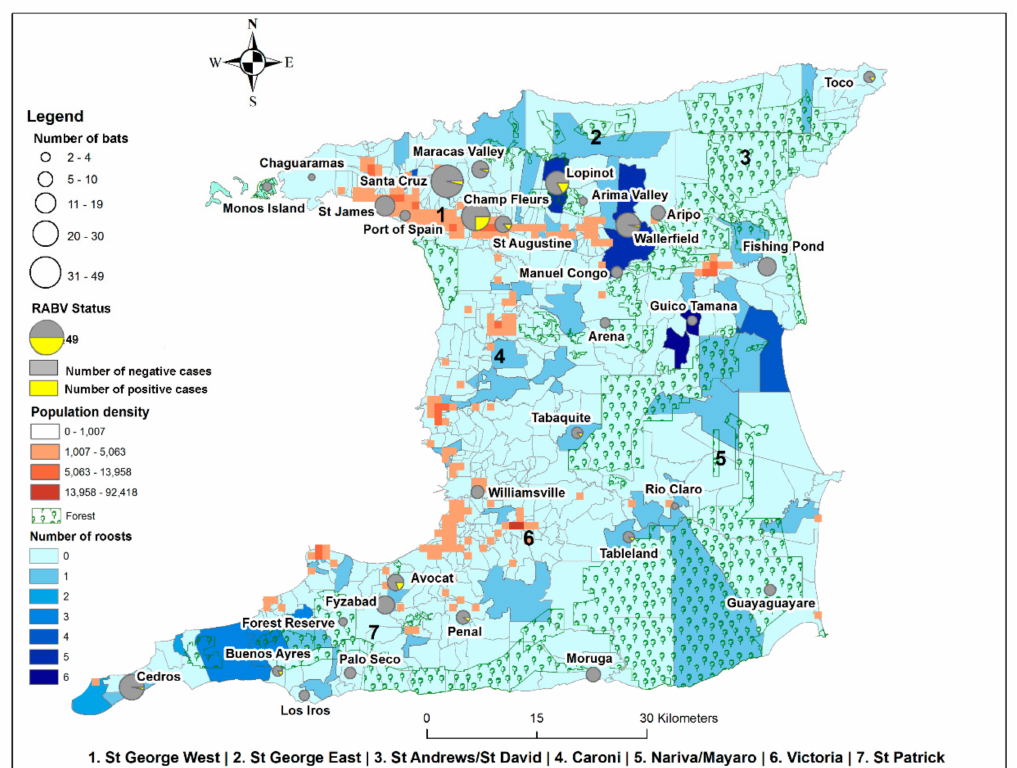
Figure 1. Geographic locations of bat specimen collection in Trinidad relative to human population density, monitored vampire bat roosts and forested areas: numbers of bats collected per site indicated by the size of the circle with the number of RVNA positive (yellow) and negative (grey) samples indicated within each circle; urbanization level indicated by the human population density and; bat roost density indicated by the number of